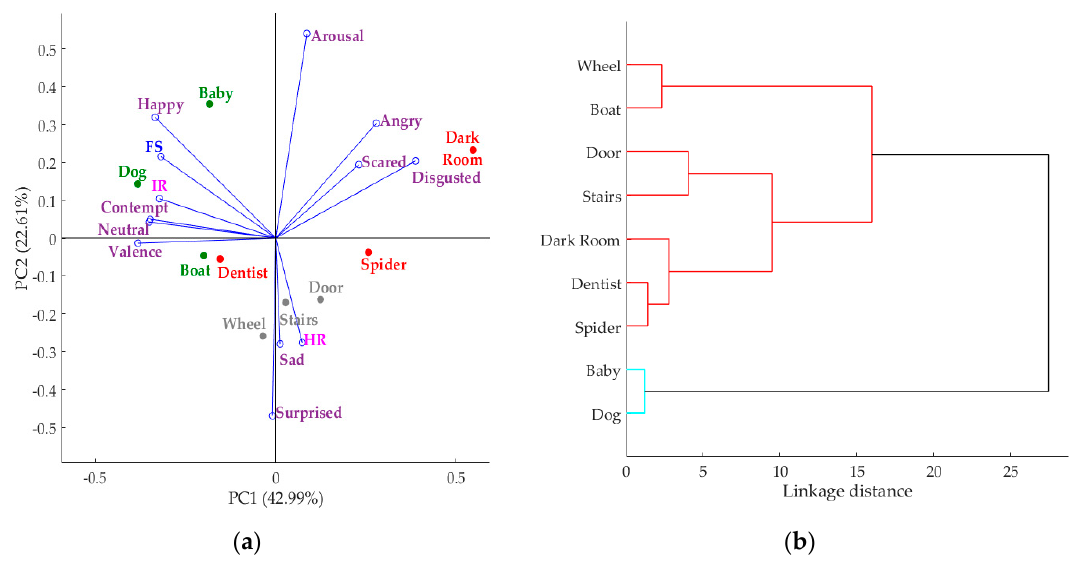
Figure 9. Multivariate data analysis showing: ( a ) principal components analysis where: IR = body temperature, HR = heart rate, and FS = face scale; and ( b ) cluster analysis where x -axis = linkage distance and y -axis = images.